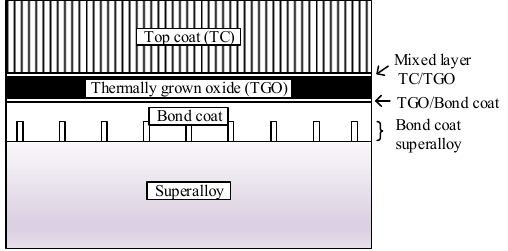
Figure 1. Thermal barrier coating and its four components. TC: Top coat; TGO: Thermally grown oxide.